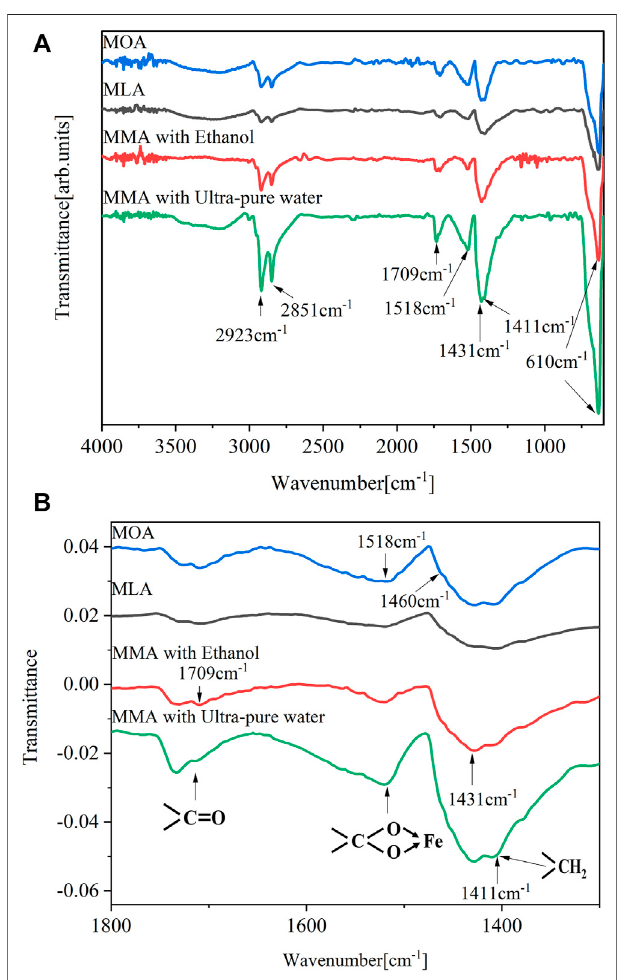
FIGURE 4 | (A) Infrared spectra images of particles in three magnetic fl uids, (B) 1,300 – 1800 cm − 1 zoomed spectra in the carboxylate region.